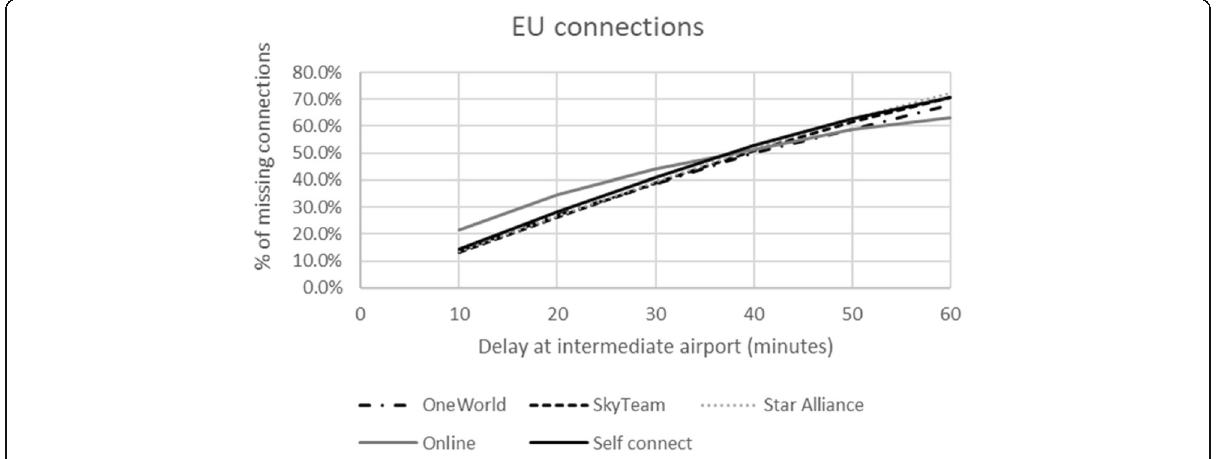
Fig. 1 Percentage of missed connections to EU destinations related to delayed arrivals at the intermediate airports